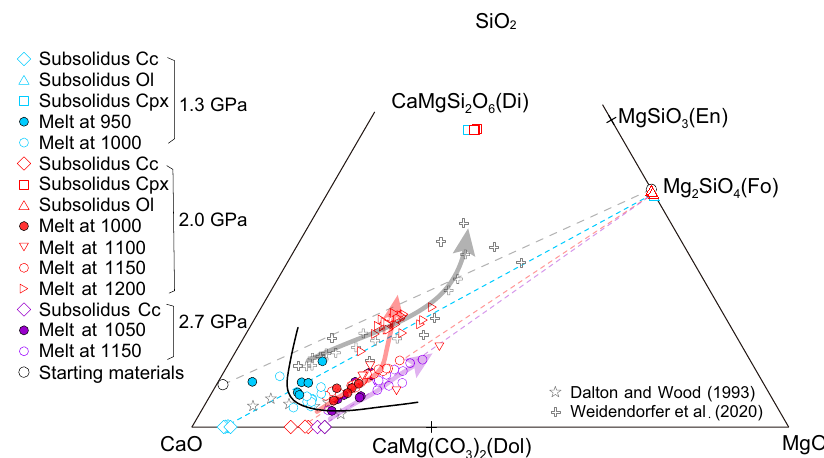
Fig. 4 Chemical compositions of experimental products. The compositions of carbonatite melts and minerals in the experiments. The minerals are from the reaction zones at the subsolidus experiments. The blue, red, and purple dotted lines represent mixing cures between olivine and Mg calcite in the reaction zones at various pressures. The red and purple arrows indicate the evolution of the melt compositions with increasing temperature. The grey dotted line represents the mixing cure between limestone and dunite using for this study. All these carbonatite melts plot on mixing lines between olivines and Mg calcites at various pressures, indicating no compositional contribution from clay impurities in the limestone. Carbonatite melts from water-rich calcite – olivine system 23 and carbonated peridotite system 67 are shown for comparison. Fo forsterite, En enstatite Di diopside, Dol